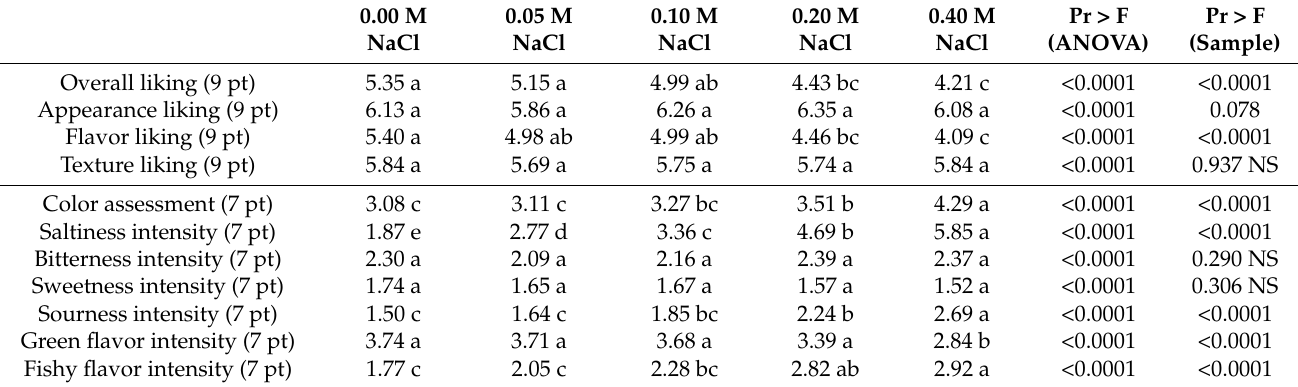
Table 1. Mean rating of all hedonic (9-point scale) and flavor intensity (7-point scale) attributes of ice plant leaf samples in response to sodium chloride (NaCl) treatment in hydroponic